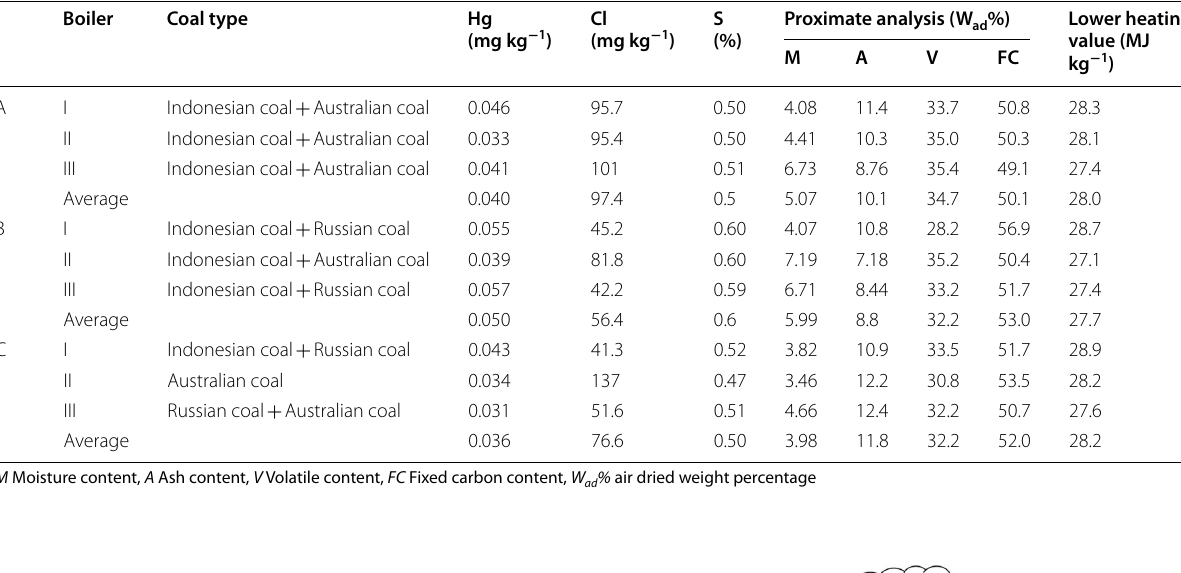
Table 1 Proximate and ultimate analyses, source and calorific value of coal samples during campaign A, B and C